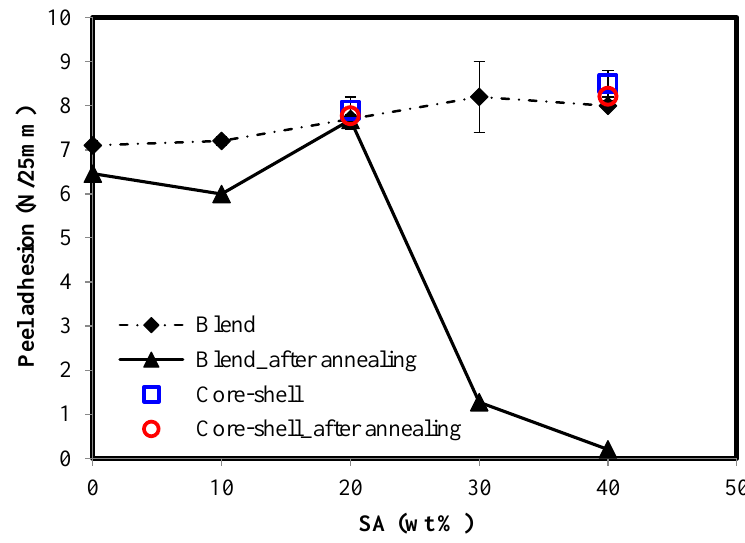
Figure 2. Effect of annealing of adhesive tapes cast from blends and core-shell latexes on their peel adhesion on stainless substrate.